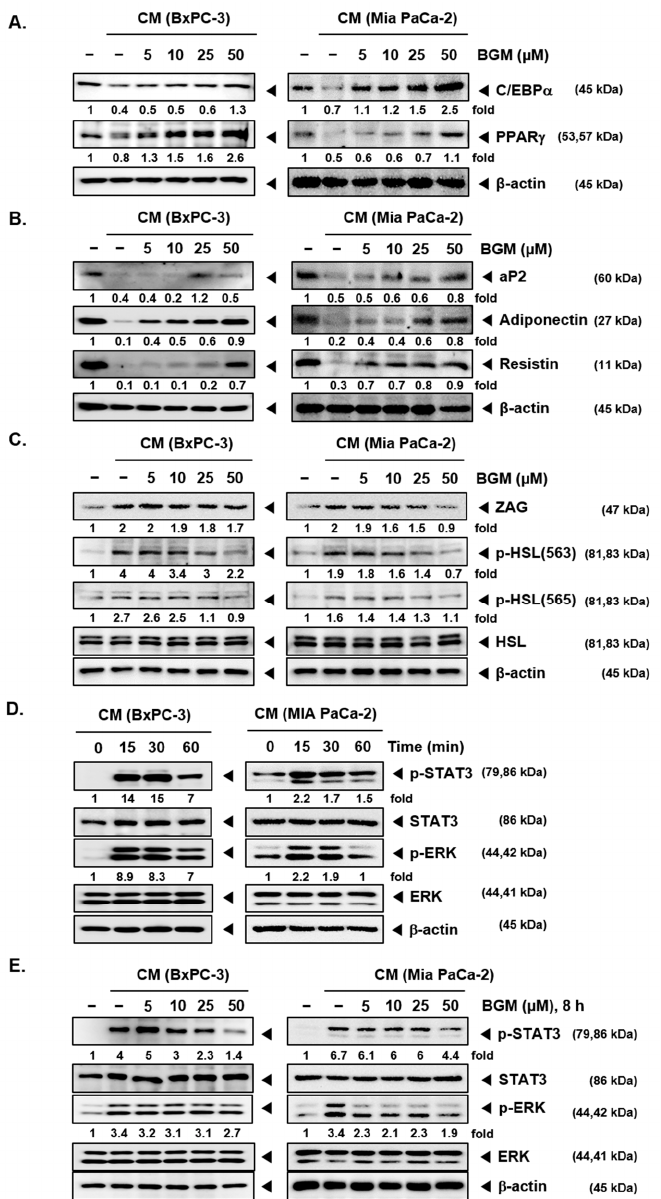
Figure 4. Induction of adipogenesis markers in differentiated 3T3-L1 cells by BGM. ( A ) 3T3-L1 cells were differentiated into adipocytes and then treated with BGM in a dose-dependent manner along with BxPC-3 and MIA PaCa-2 CM for 2 days. The expression levels of adipogenesis-related factors C/EBP α and PPAR γ were analyzed by Western blot analysis. ( B ) The levels of adipocytes markers aP2 , adiponectin, and resistin were analyzed by Western blot analysis. ( C ) 3T3-L1 cells were incubated with BxPC-3 and MIA PaCa-2 CM for 8 h. The expression levels of zinc-a2 glycoprotein (ZAG), p-hormone-sensitive lipase (HSL), and HSL were evaluated by Western blot analysis. ( D ) 3T3-L1 cells were incubated with BxPC-3 and MIA PaCa-2 CM in a time-dependent fashion. ( E ) The differentiated 3T3-L1 cells were treated with BGM (0, 5, 10, 25, and 50 µ M) for 8 h and then incubated with BxPC-3 and MIA PaCa-2 CM for 15min. The expression levels of p-STAT3, STAT3, p-ERK, and ERK were observed by Western blot analysis. All the experiments were performed independently at least 3 times, and representative data are